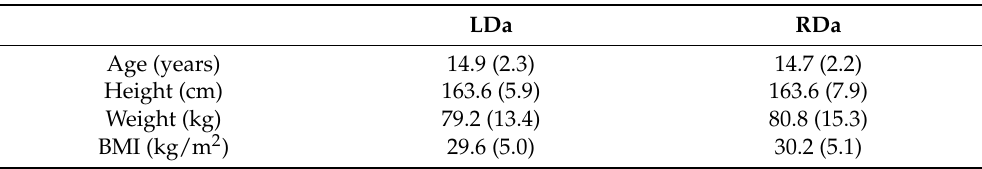
Table 1. Descriptive data for the female adolescent participants in the low dairy product intake (LDa; n = 23) and recommended dairy product intake (RDa; n = 24)